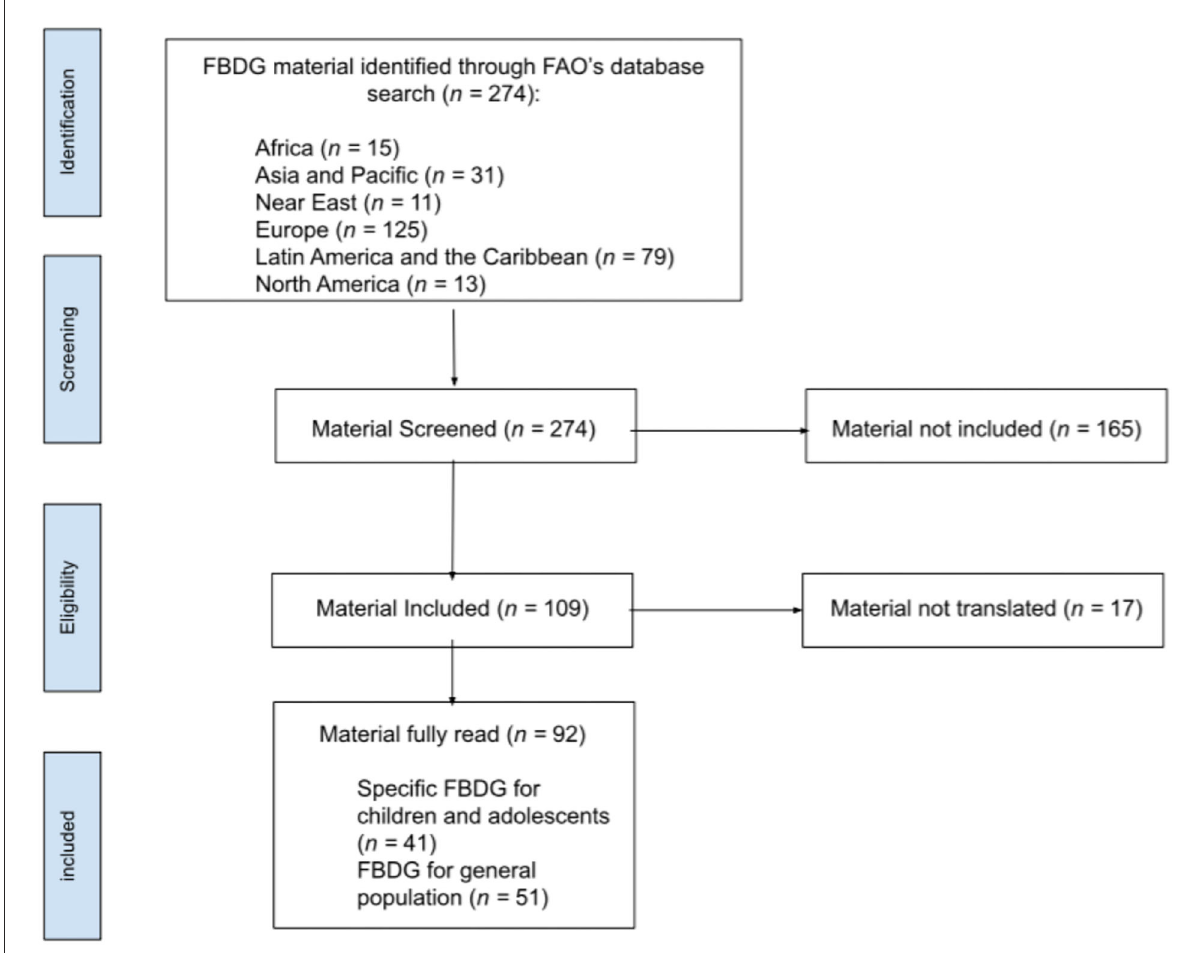
FIGURE1 Flow diagram representing the selection process of material from FAO’s